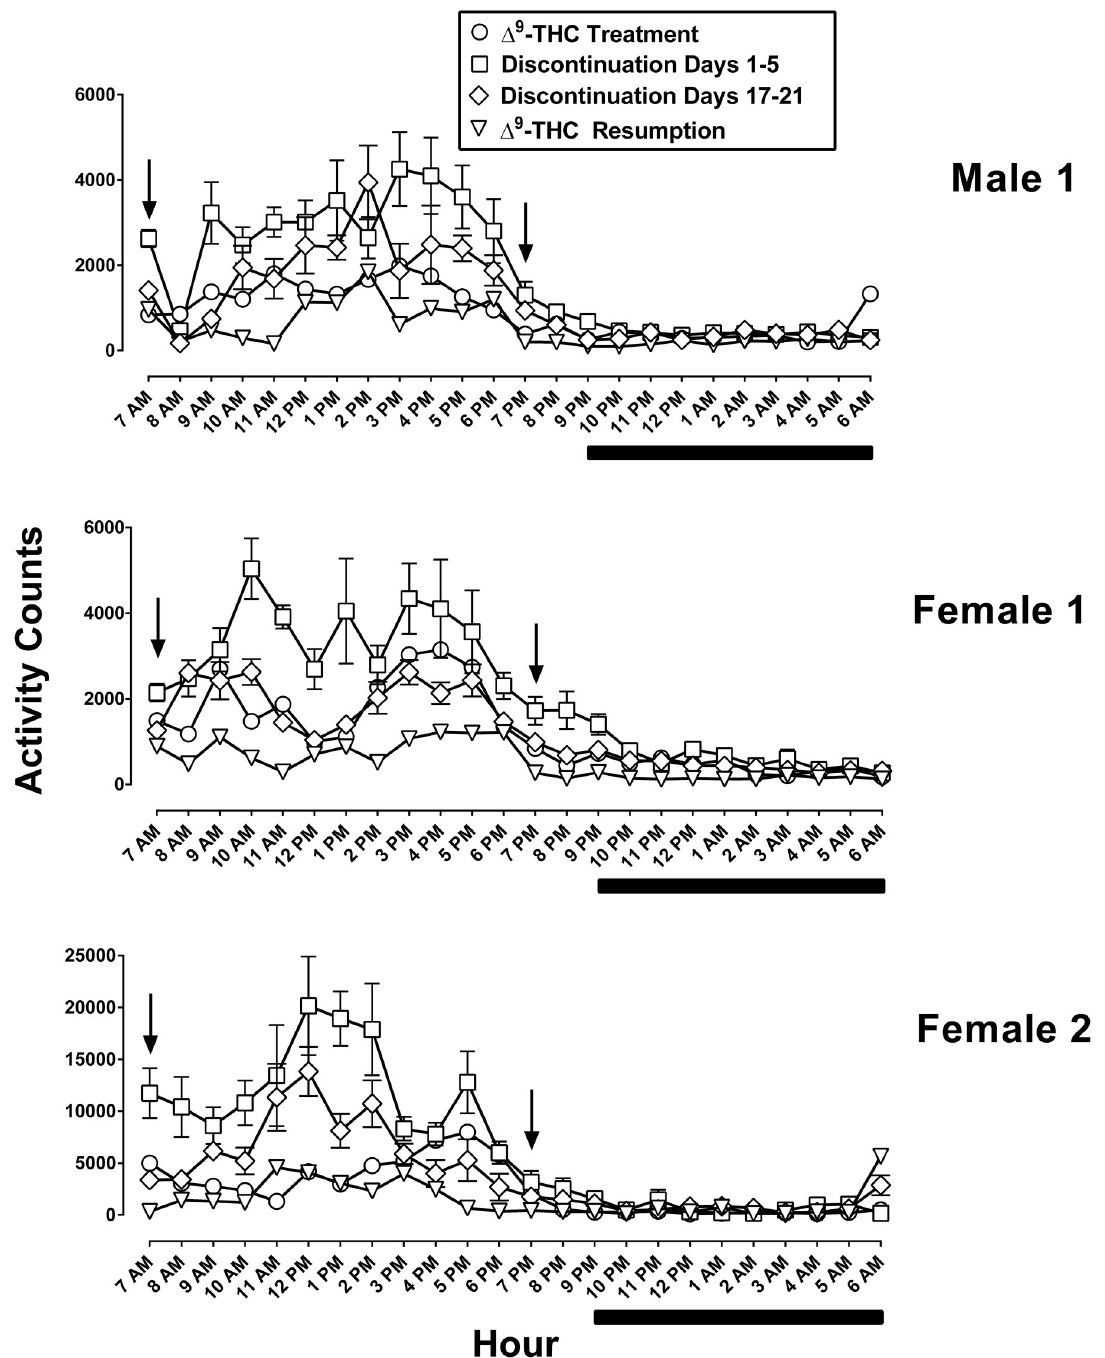
Fig 1. Absolute activity counts cumulated in 1-h bins and expressed for each h of the 24-h light/dark period. Each panel represents data from an individual monkey. Symbols are an average of 5 consecutive days including the 5 days immediately preceding discontinuation of Δ 9 -THC treatment (circles), the first and last 5 days of discontinued treatment (squares and diamonds, respectively), as well as the first 5 days of resumption of Δ 9 -THC treatment (triangles). The arrows indicate the time of Δ 9 -THC (1 mg/kg) or vehicle administration; vehicle was administered instead of Δ 9 -THC during the discontinuation phase. Below the abscissae the solid line denotes the dark period. Note the larger range of values on the ordinate of the lower panel as compared with the middle and top panels.